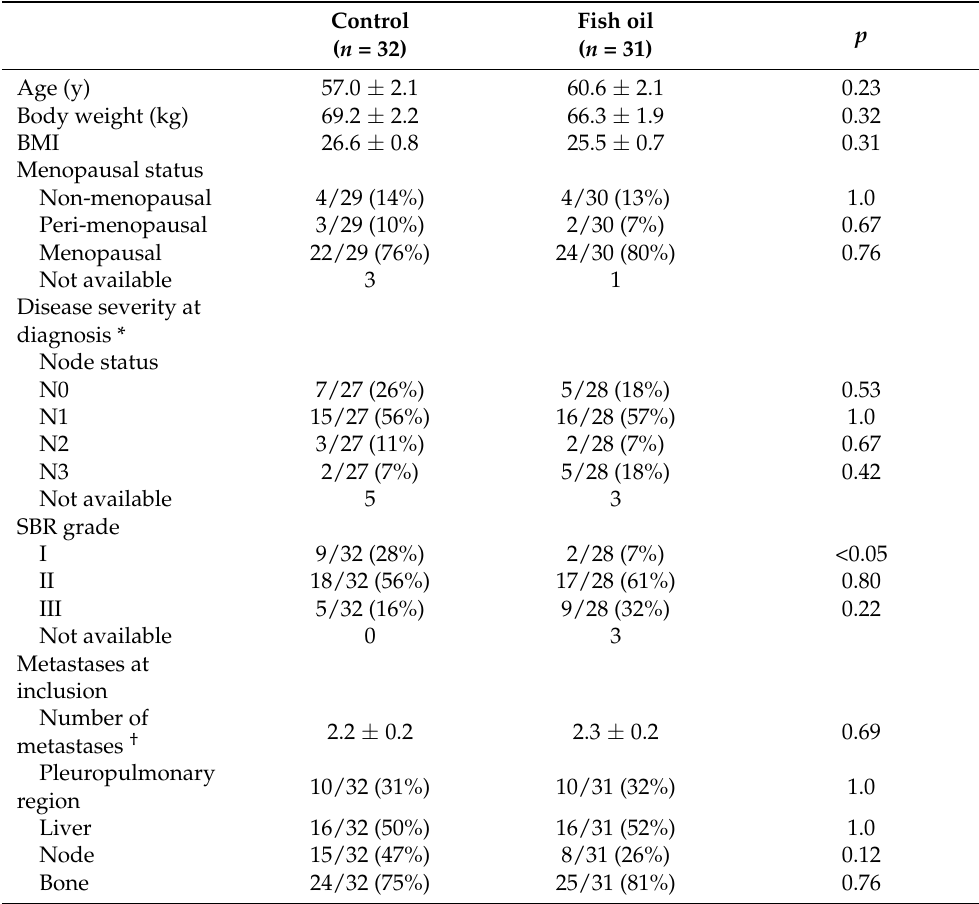
Table 2. Patient